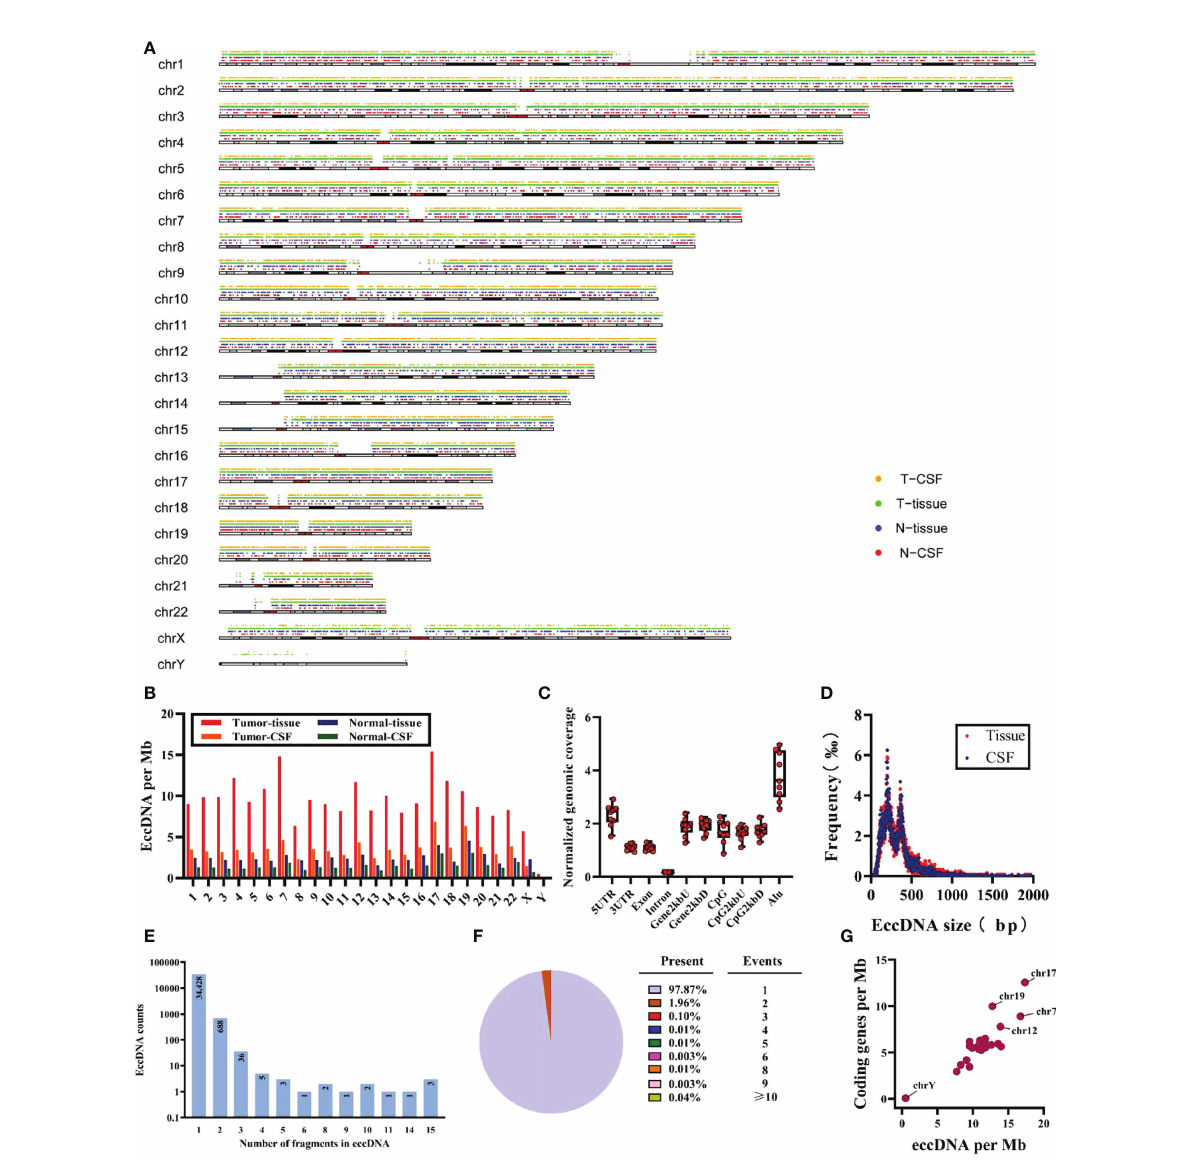
FIGURE 2 Characteristics of total eccDNAs. (A) Distribution for eccDNAs of four sample groups in chromosomes. (B) Frequency (per Mb) of distribution of eccDNAs in 23 pairs of chromosomes for each group. (C) The distribution of all samples of eccDNAs in different genomic regions. (D) Size distribution and relative abundance of eccDNAs in tissue (red) and CSF (blue), data from all samples. (E, F) The counts and proportion of eccDNAs in all samples cover different numbers of gene fragments. (G) The ratio of coding genes/Mb and eccDNAs/Mb in 23 pairs of chromosomes from analysis of all samples. Mb,